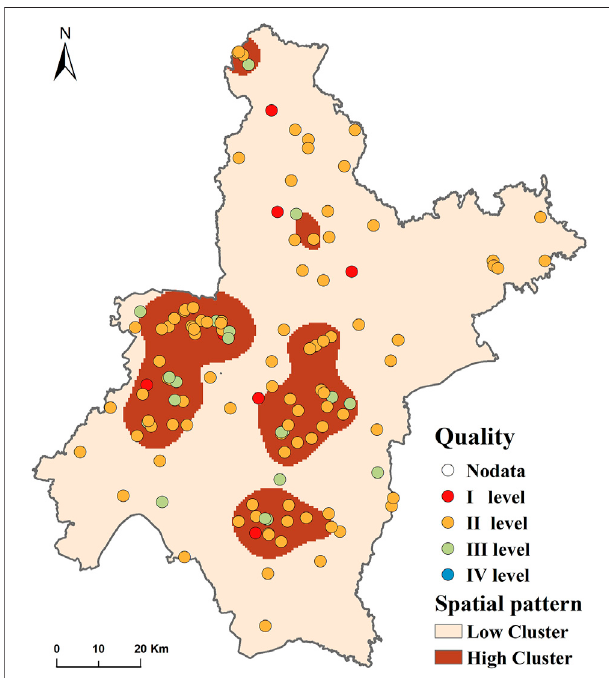
FIGURE8| Qualityscoreandspatialkerneldensity distribution ofleisure